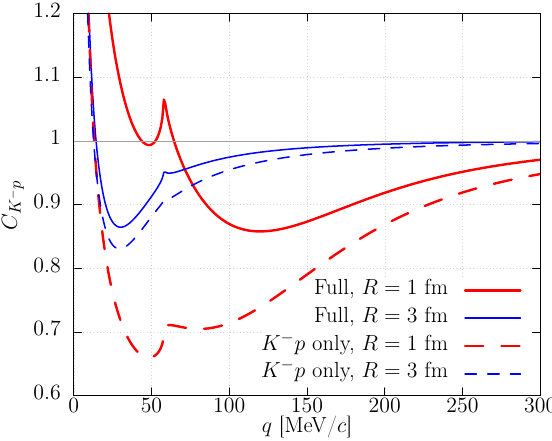
Figure 2. K − p correlation function with R = 1 fm (thick lines) and R = 3 fm (thin lines). The long- dashed line denotes the result with K − p component only. The solid lines show the full calculation result in which the contributions from all coupled-channel components are